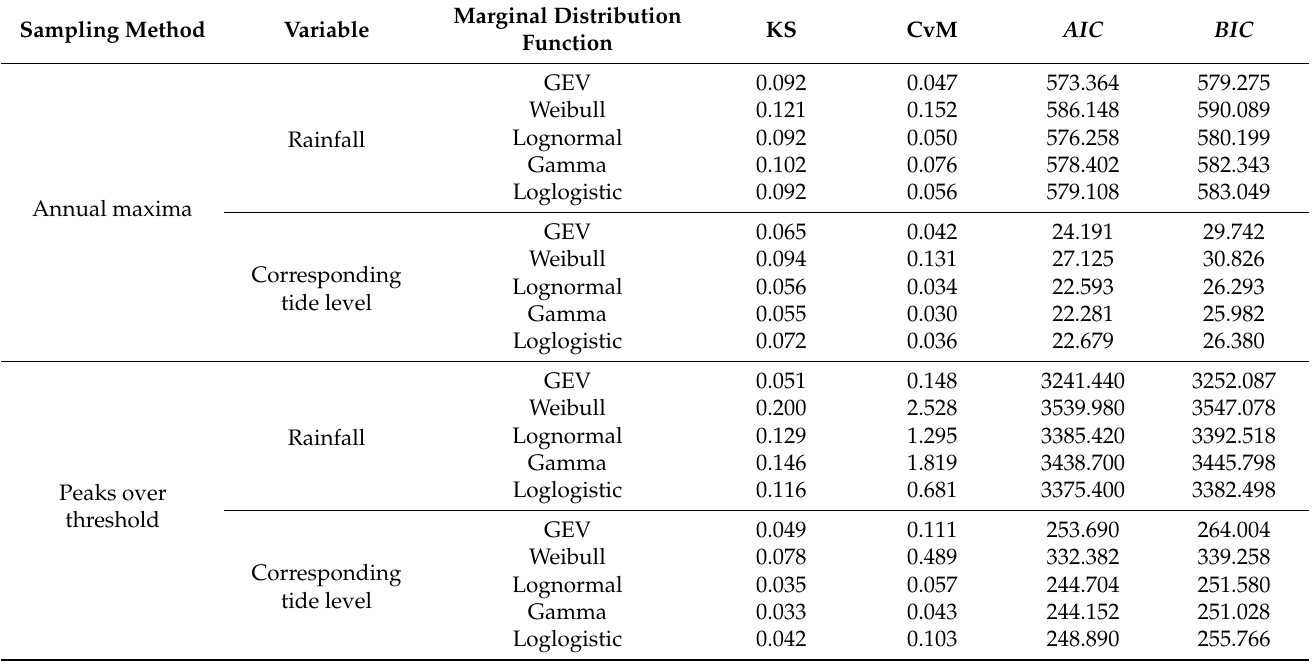
Table 2. Goodness-of-fit test statistics for marginal